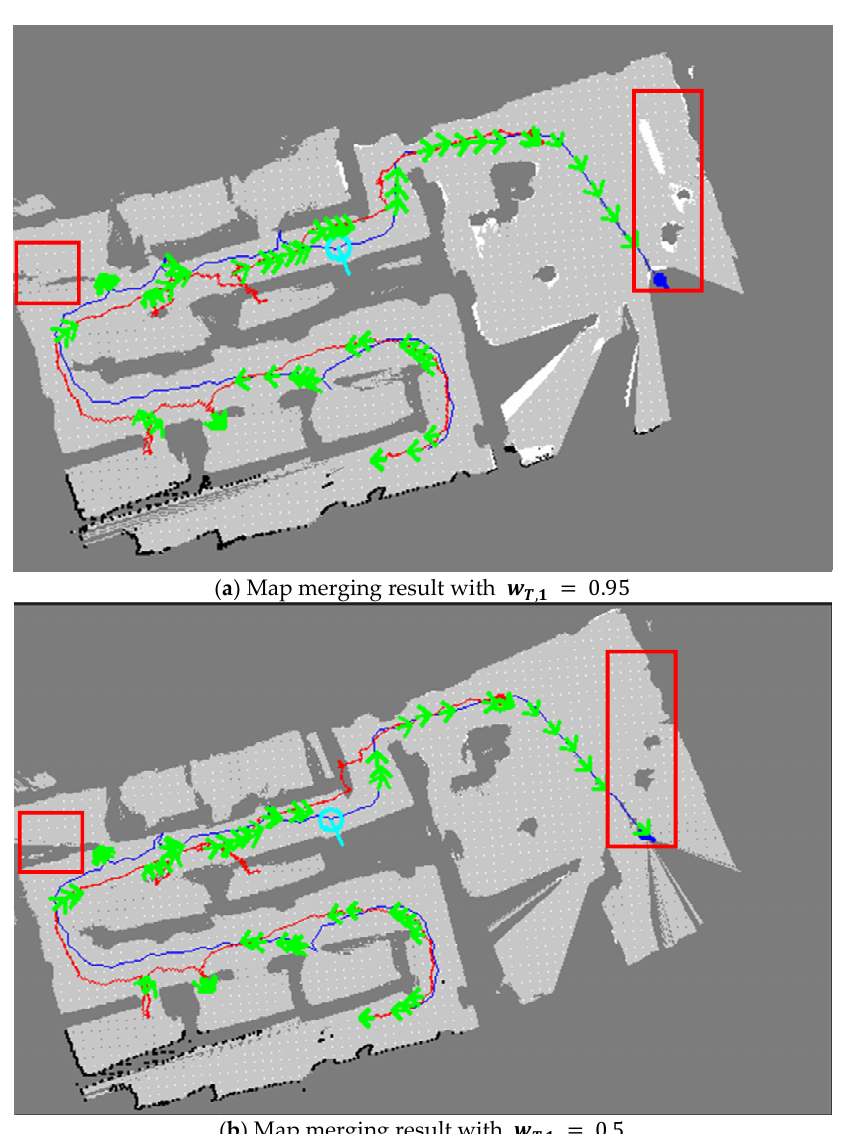
Figure 10. Map merging results with the TSD grid update. By comparing the two maps, a more correct map was built as shown in ( b ).